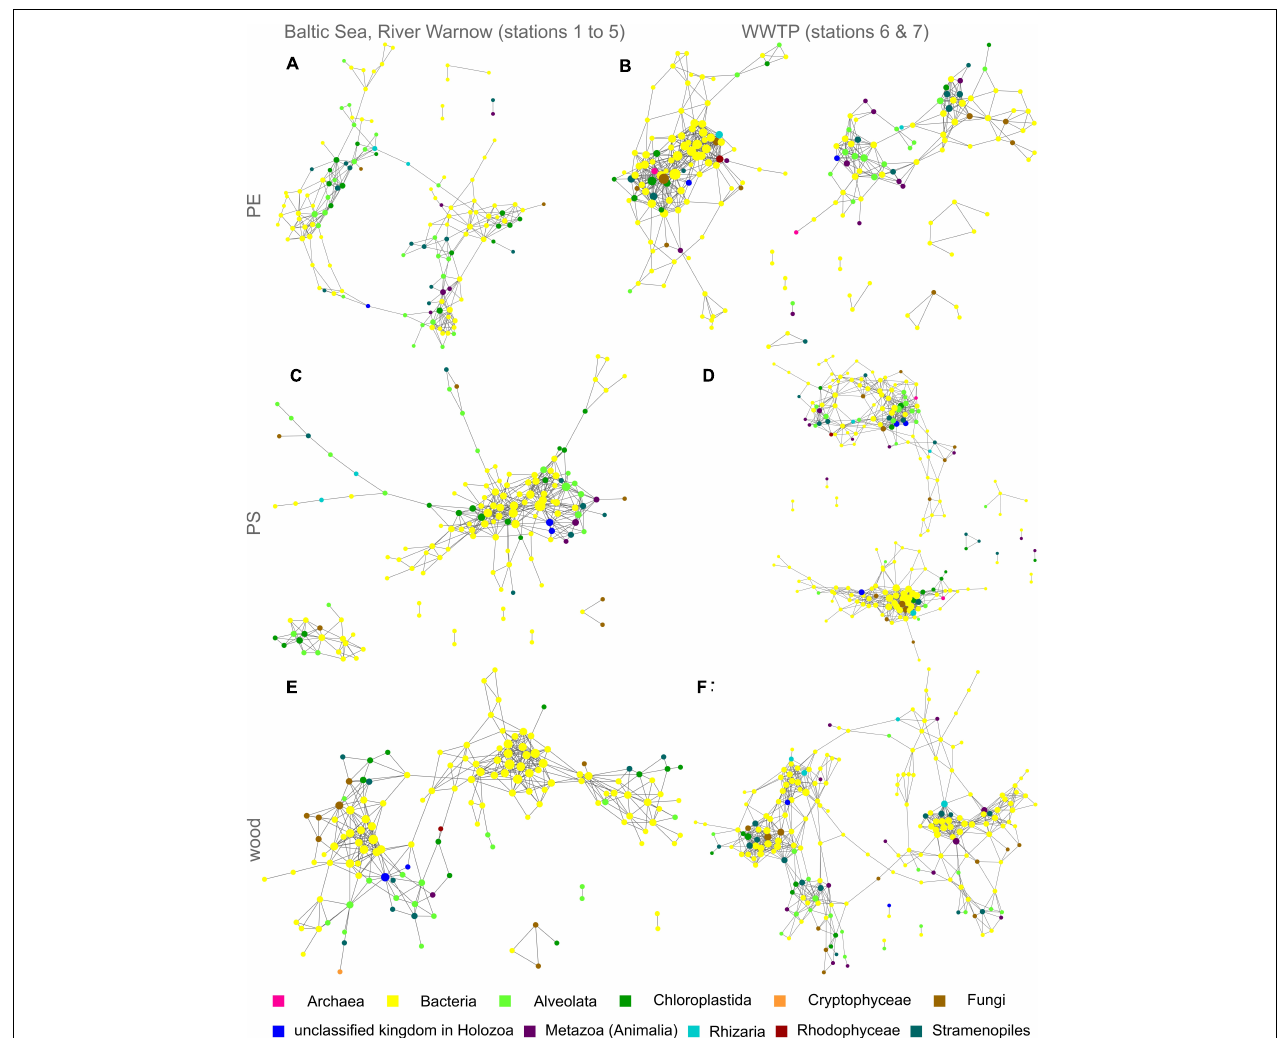
FIGURE 4 | Co-occurrence networks of prokaryotic and eukaryotic taxa for PE, PS, and wood from both incubation experiments I (Baltic Sea to River Warnow, stations 1 to 5) and II (WWTP, stations 6 and 7). Each node is a taxon and the node diameter increases with the number of direct neighbors. Edges represent significant positive correlations ( p < 0.05) between nodes/taxa. Colors indicate different kingdoms. (A) PE in Baltic Sea, River Warnow (stations 1 to 5); (B) PE in WWTP (stations 6 and 7); (C) PS in Baltic Sea, River Warnow (stations 1 to 5); (D) PS in WWTP (stations 6 and 7); (E) Wood in Baltic Sea, River Warnow (stations 1 to 5); (F) Wood in WWTP (stations 6 and